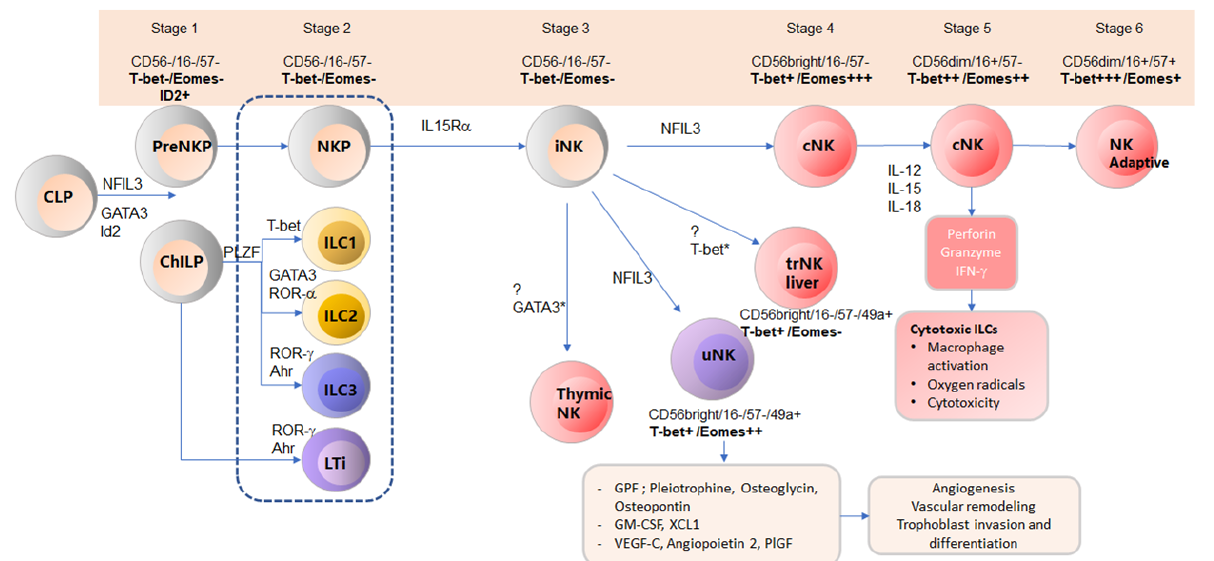
Figure 1. Ontogeny of NK cells. Each stage of NK cell development is characterized by various transcription factors and surface cell markers. NK cells start the differentiation with CLPs under the influence of either NFIL3 or GATA3 and ID2 to produce preNK and ChILP. Stage 1 NK cells include preNKP and ChILP and are characterized by CD56 – /CD16 – /CD57 – /T-bet – /Eomes – /ID2 + . PreNKP cells differentiate into NKP cells (stage 2). Stage 2 NK cells include NKP, ILC1, ILC2, ILC3, and LTi and are